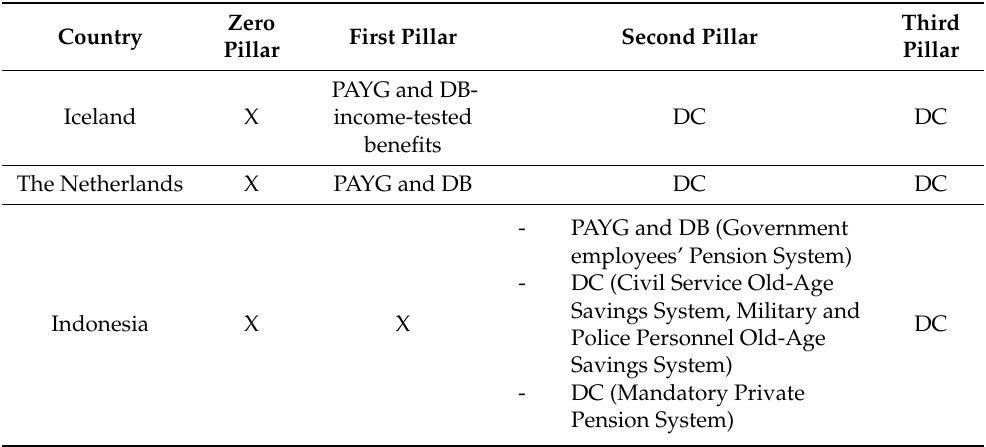
Table 2. Comparison of Pension System in Iceland, the Netherlands, and Indonesia. Zero Third Country First Pillar Second Pillar Pillar Pillar PAYG and DB- Iceland X income-tested DC DC benefits The Netherlands X PAYG and DB DC DC - PAYG and DB (Government employees’ Pension System) - DC (Civil Service Old-Age Savings System, Military and Indonesia X X Police Personnel Old-Age Savings System) - DC (Mandatory Private Pension System)